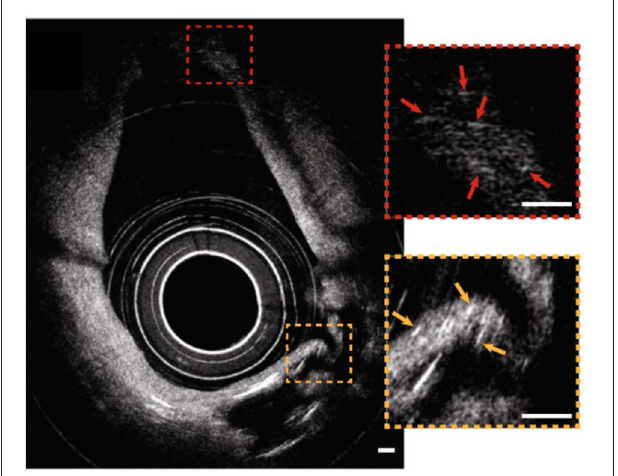
FIGURE 6 | Catheter-based intravascular µ OCT for cholesterol crystals in the human cadaver coronary ex vivo. Circumferential image showing that µ OCT was capable of resolving small cholesterol crystals at distances close to the sheath (a couple hundred microns, orange inset) and far from the sheath ( ∼ 1mm, red inset) simultaneously. Scale bars, 100 µ m. Figure and capture reprinted with permission from Yin et al. ( 35).